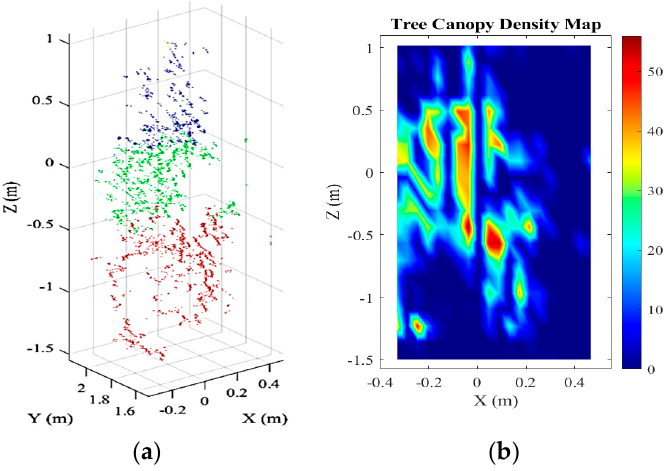
Figure 2. Canopy foliage density map ( a ) Tree canopy points without the trunk, trellis wires, and support pole points divided into sections; ( b ) canopy density map considering the number of leaves (per grid area) [47] (used with permission).